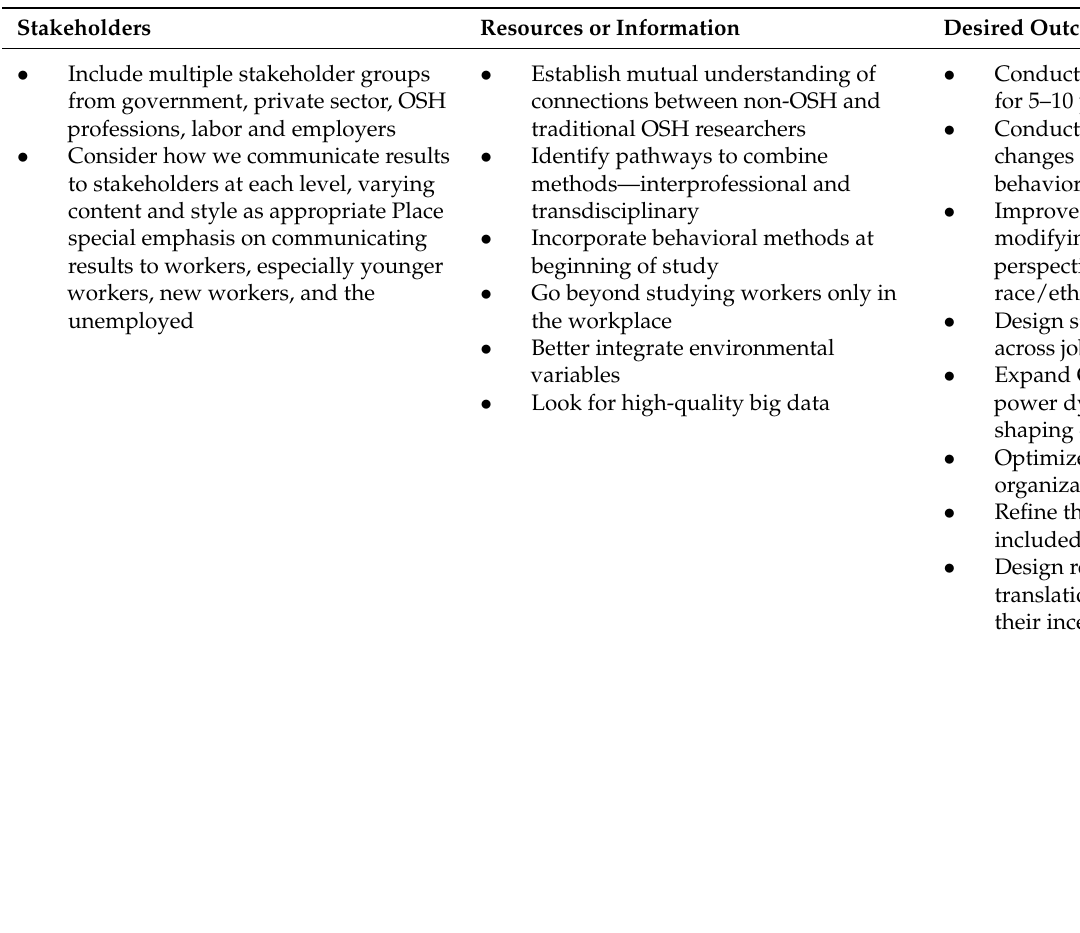
Table 1. Summary of Key Elements in the Horizontal